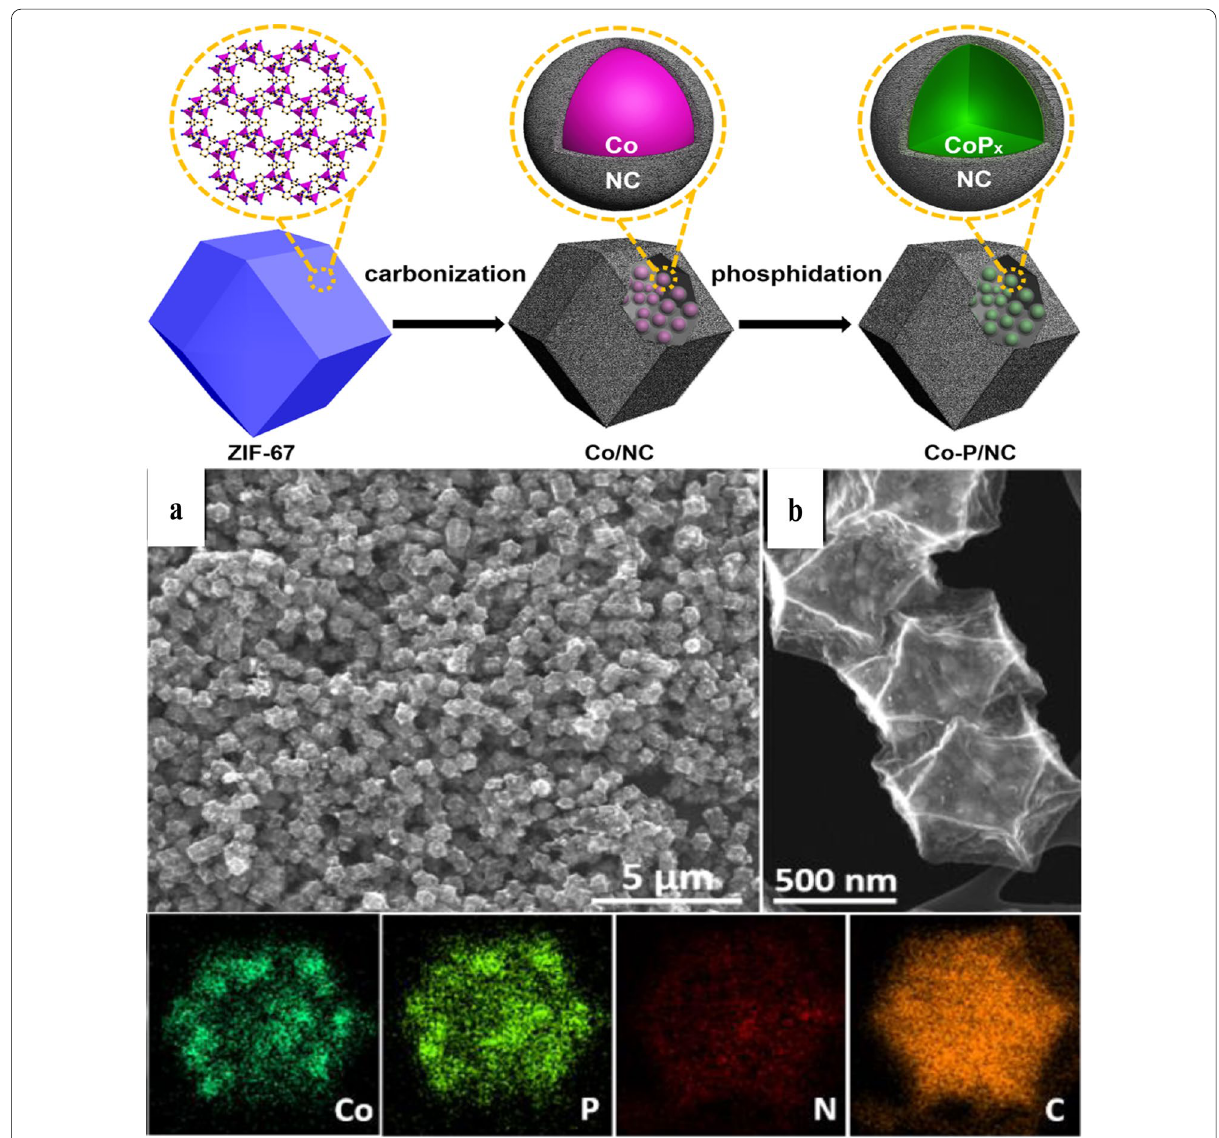
Fig. 4 Schematic representation of the fabrication of Co-P/NC nanopolyhedrons. a , b are the SEM image and high magnification SEM image. The elemental mapping of Co-P/NC show the even elemental distributions of Co, P, N, and C. Reproduced with permission from Ref. [50].